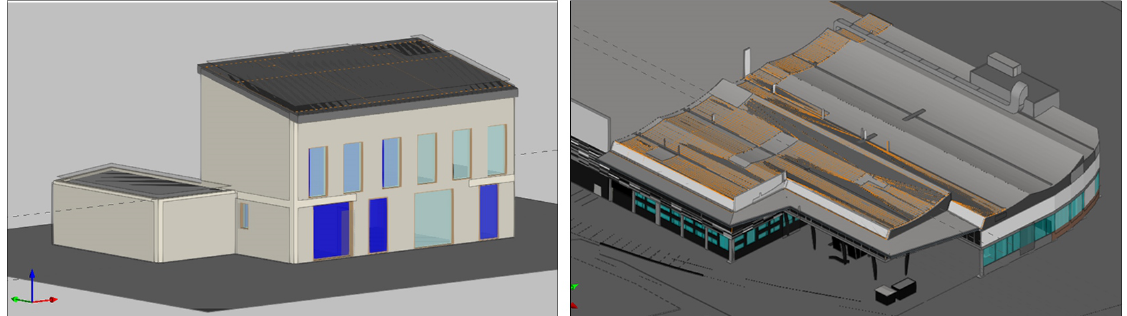
Figure 4. IFC files imported into Open BIM Analytical